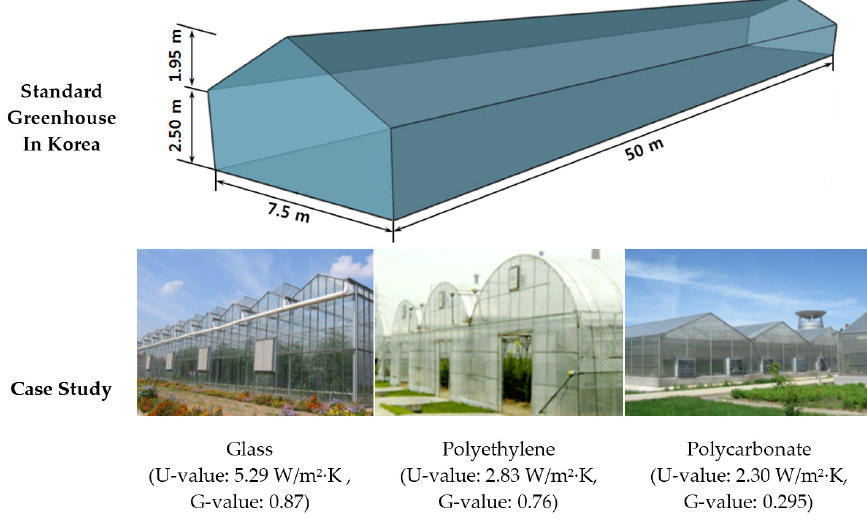
Figure 7. Greenhouse model.